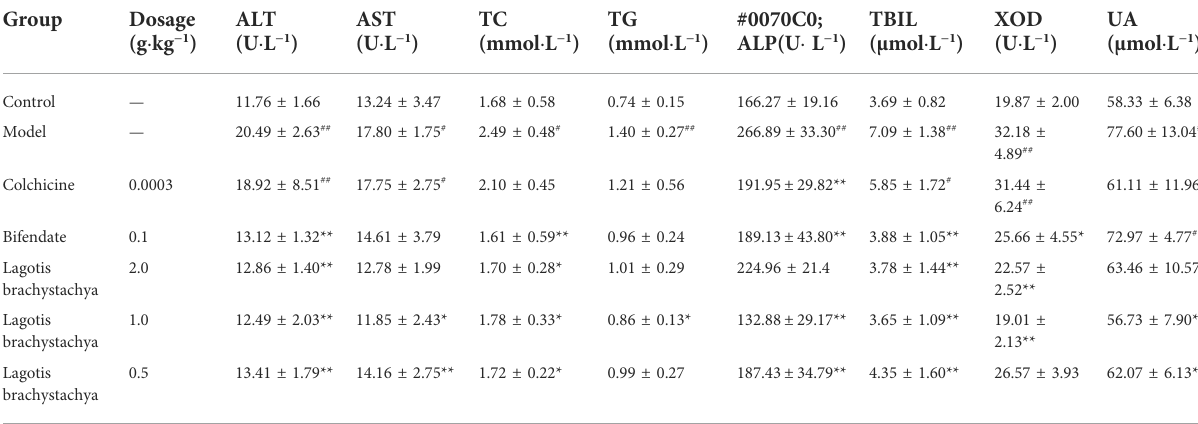
compared with control group, # # p < 0.01; Compared with the model group * p < 0.05, * * p < 0.01.